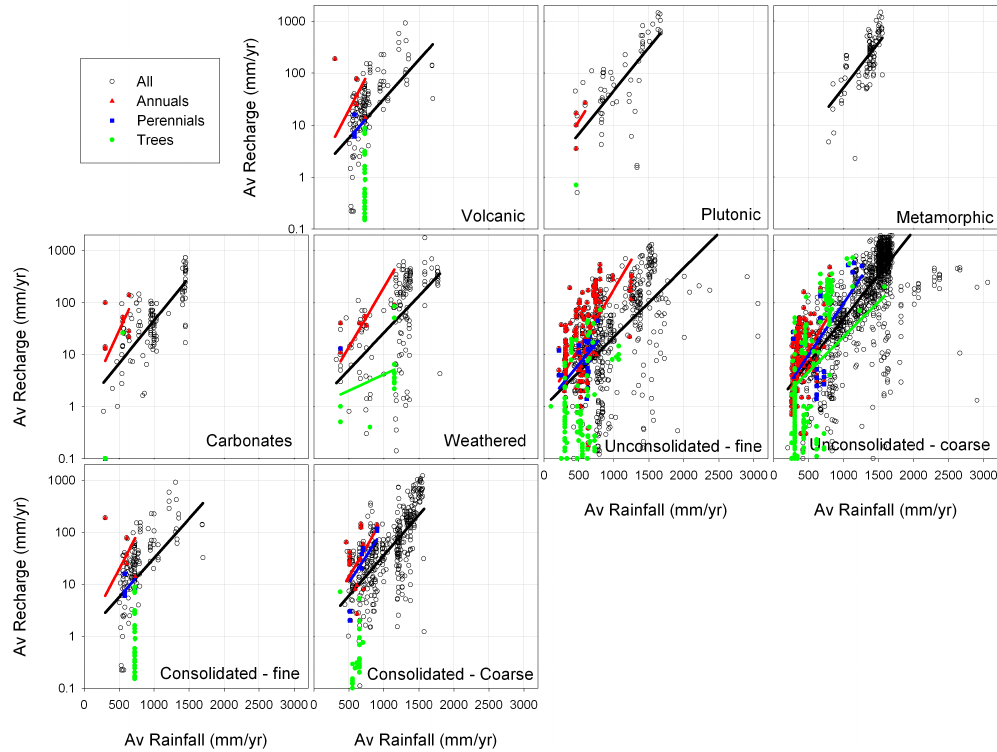
Fig. 9. The relationship between rainfall and recharge when categorised by surface geology groups. The class “all” is all the recharge estimates irrespective of vegetation